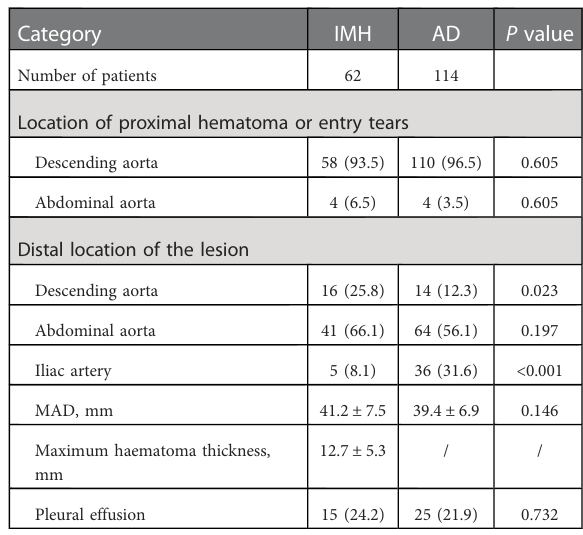
TABLE 2 Ct imaging of type B IMH and type B